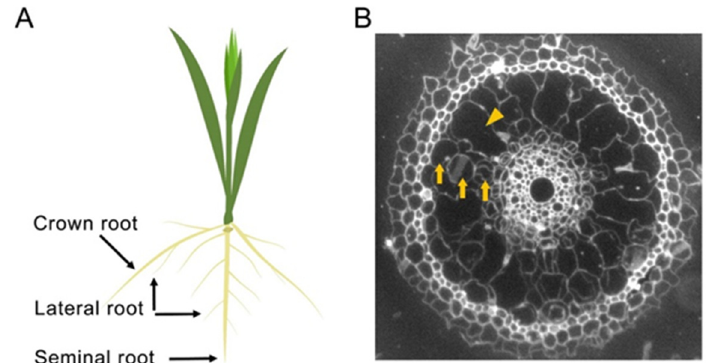
Figure 2. Anatomy of rice roots. ( A ) A schematic of rice root system composed of seminal, crown and lateral roots. ( B ) A radial anatomy of rice roots was visualized by transverse sectioning of 12-day-old seminal roots. Arrow and arrowhead indicate cortex and aerenchyma, respectively.